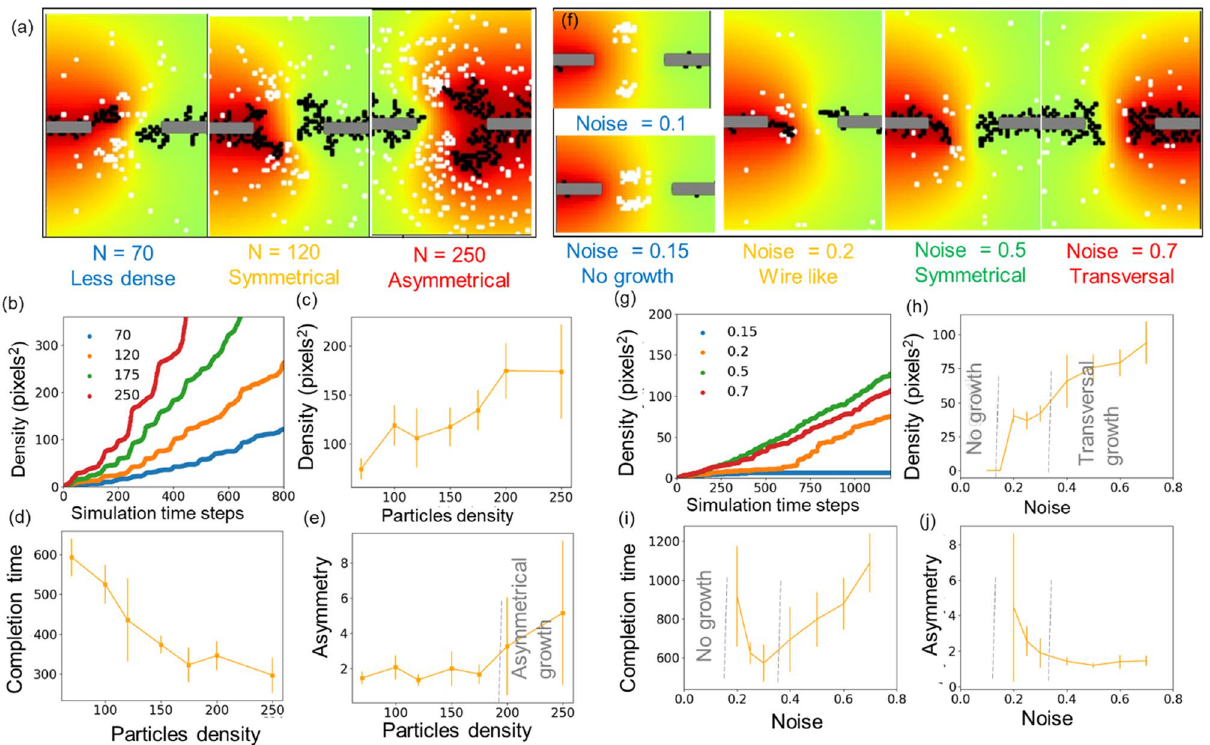
Figure 4. Effect of simulation parameters on the growth process. ( a ) The dendrites obtained at variable particle density N = 70, 120 and 250. ( b ) The growth process for variable particle density. ( c ) The density of dendrites before being close to each other. ( d ) The variation in completion time with increase in particles density and ( e ) asymmetry parameter compared for dendrites obtained for different particle densities. ( f ) Various morphologies at increasing value of noise ( ƞ ). ( g ) The time evolution of dendrites’ density for variable noise values. ( h ) The density of dendrites before completion and ( i ) corresponding completion time for variable noise values. ( j ) Asymmetry parameter compared for dendrites obtained at different noise